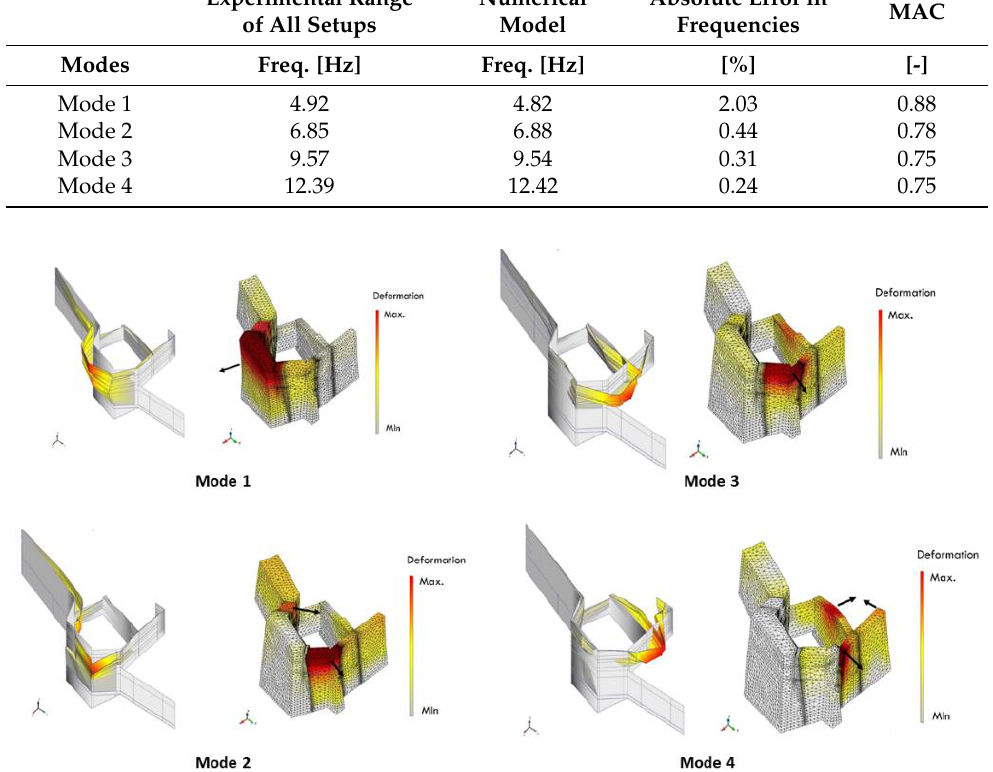
Figure 22. Comparison of experimental (dynamic identification) and numerical (eigenvalue analysis) modal shapes. Black arrows in the numerical results indicate the direction of movement.